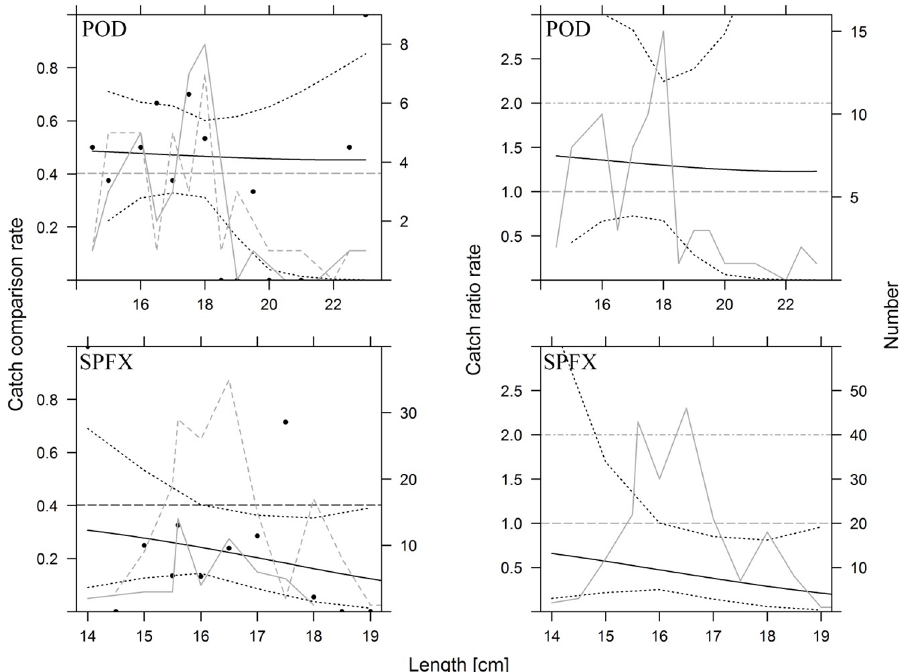
Fig. 5. Catch comparison rate (left column) and catch ratio rate (right column) for the longline deployments with one and two days soaking time (solid black curves) for fi sh species. Dots represent the experimental rates. Thin black dotted curves represent the 95% CI for the catch comparison curves. Dark grey solid curves (left column) represent summed and raised catch populations for deployments with two day soaking time. Dark grey dashed curves (left column) represent summed and raised catch population for deployments with one day soaking time. Dark grey dashed curves (right column) represent total summed and raised catch population for both deployments with one and two day soaking time. Horizontal dark grey dashed lines represent baselines for no effect of soaking time on the catch performance. Horizontal dark grey dot-dashed line represents line where longlines soaked for two days are catching twice as much as longlines soaked for one day. POD: Poor cod; SPFX: Blotched picarel.